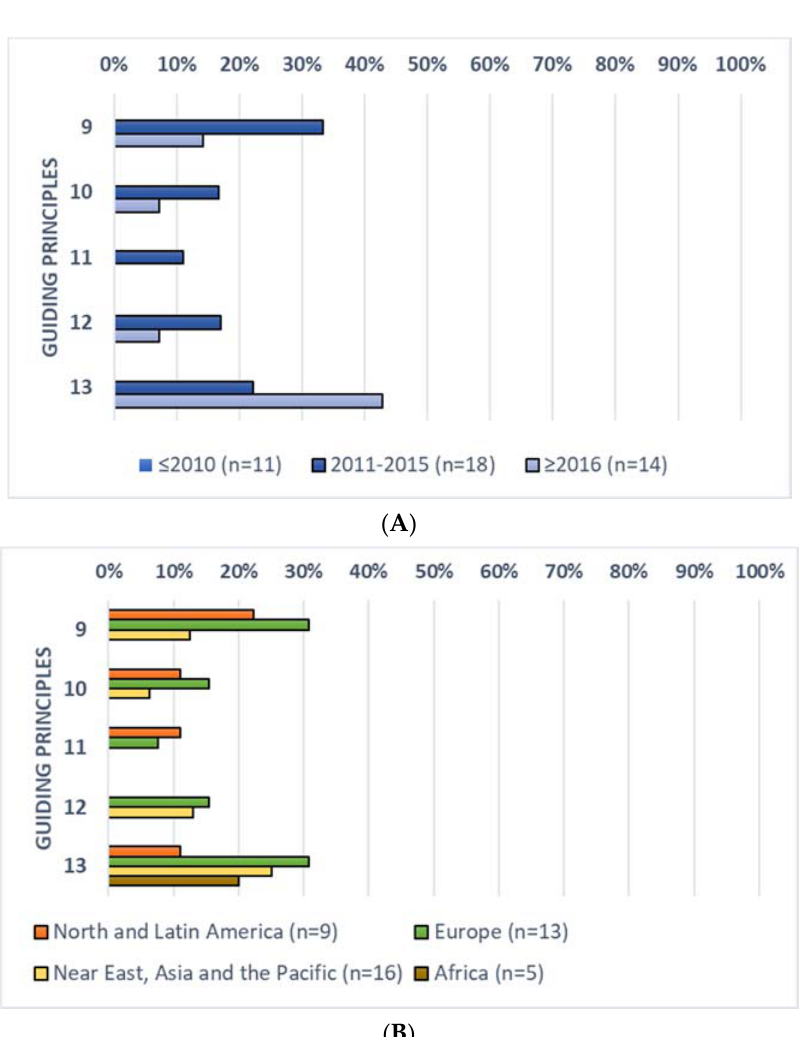
Figure 3. Rate of inclusion of the guiding principles for sustainable healthy diets related to environmental impact by the 43 FBDGs included in the evaluation, divided by period of publication ( A ) and geographical macro-area ( B ).